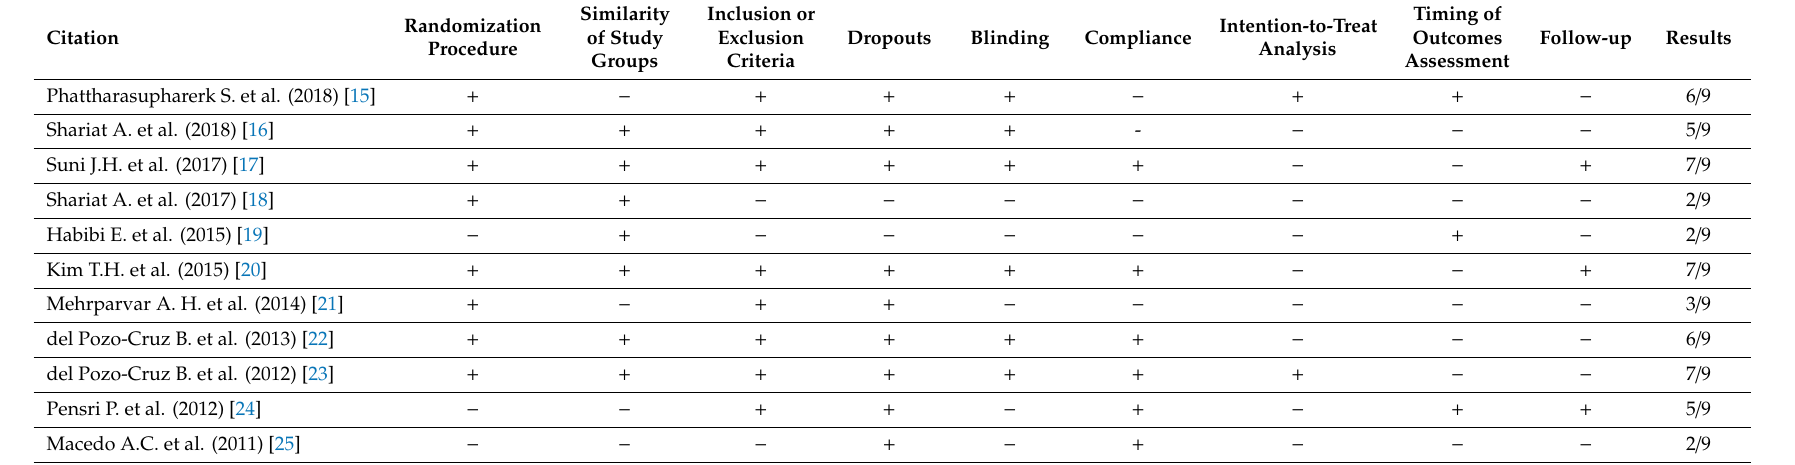
Table 2. Quality assessments of intervention